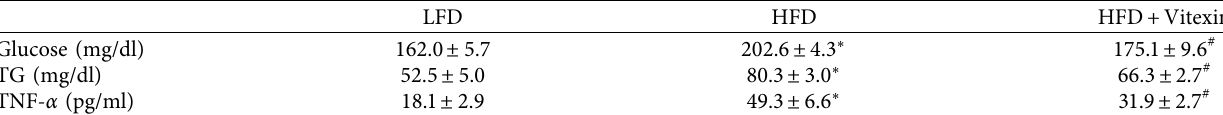
Serum levels of glucose, TG, and proinflammatory cytokines including TNF- α in mice fed with a LFD, a HFD and a HFD with 5mg/kg BW/day vitexin. LFD, low-fat diet; HFD, high-fat diet; HFD+Vitexin, high-fat diet plus vitexin at 5mg/kg BW/day. Values represent means ± SE ( n � 8 − 9). ∗ P < 0 . 05 vs. LFD; # P < 0 . 05 vs.